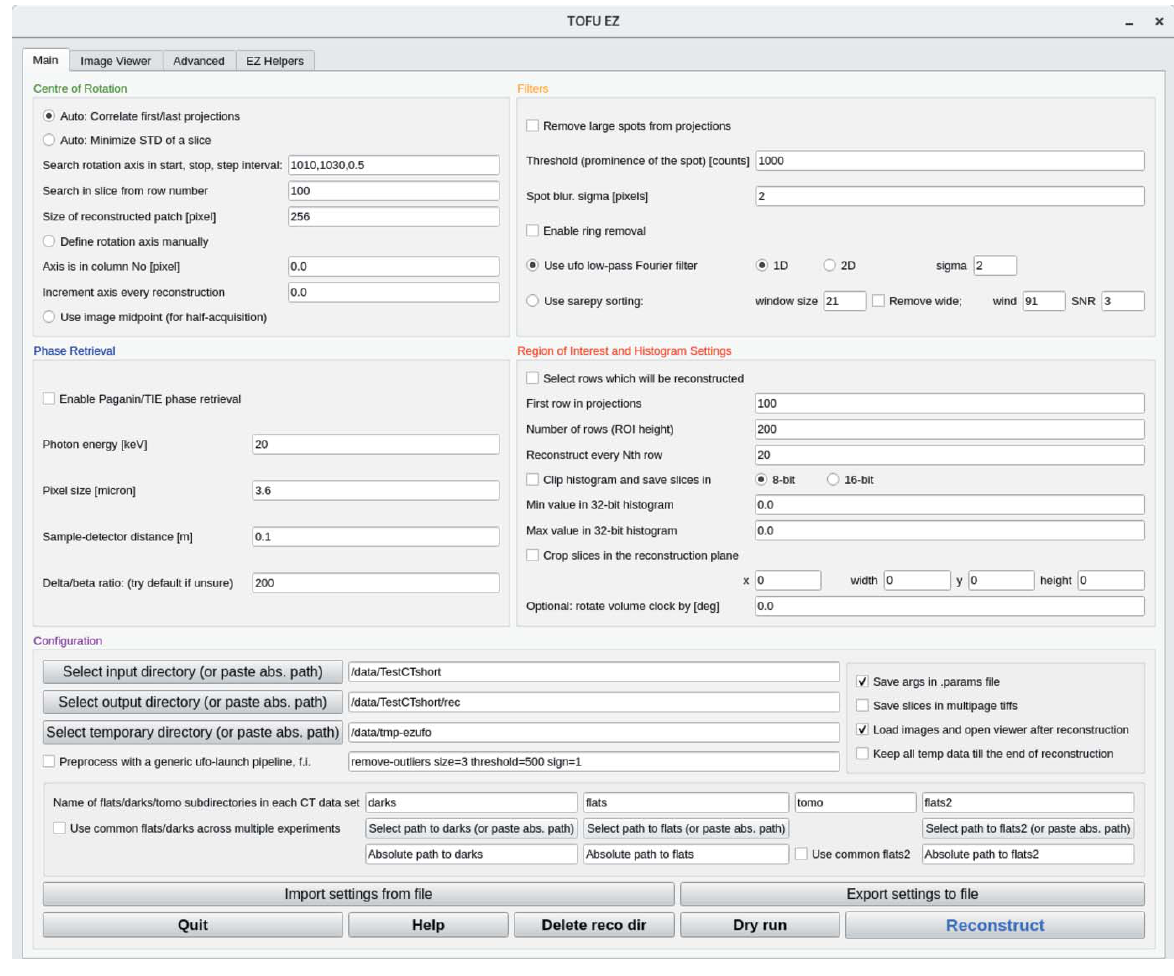
Figure 4 Main window of the tofu ez